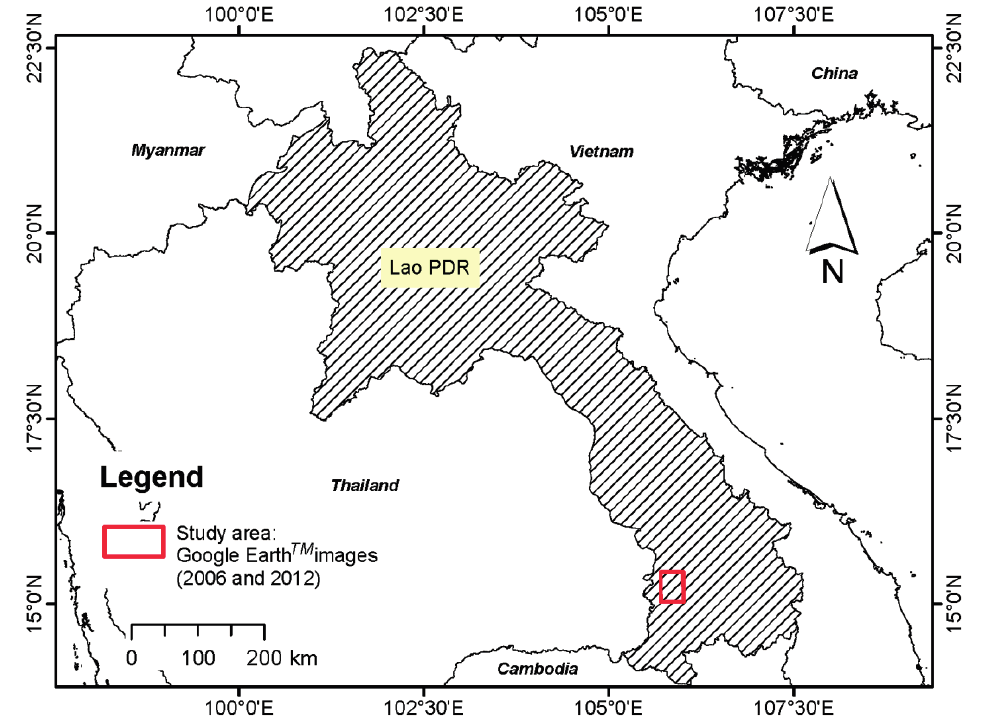
Figure 1. Location of the study area in the south of the Lao